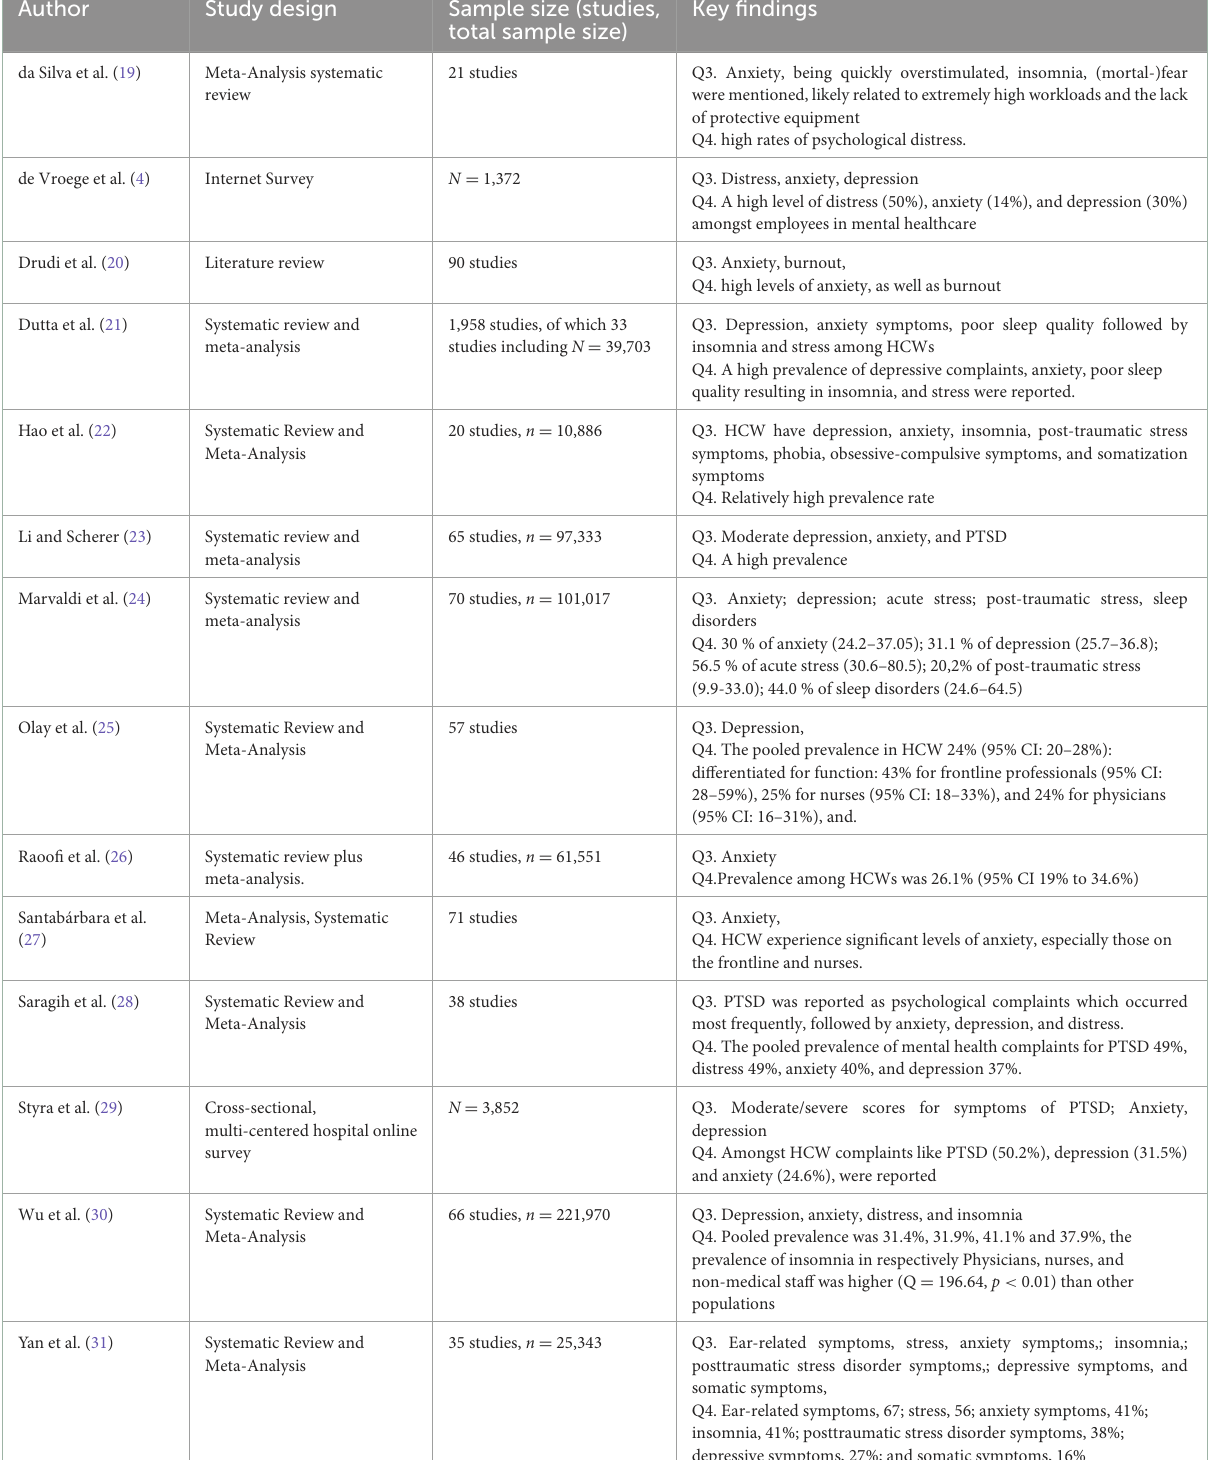
TABLE 2B Overview of the characteristics of the studies answering Q3 and